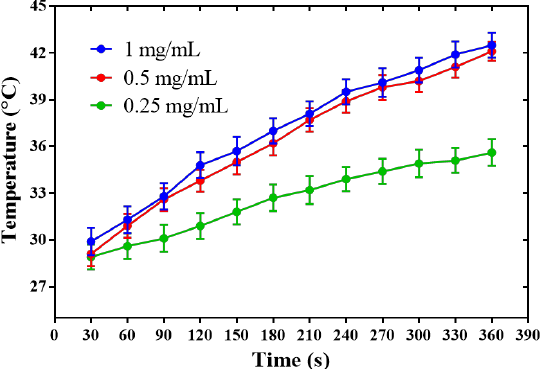
Figure 2. Photothermal conversion performance of PPY NPs with different concentrations.